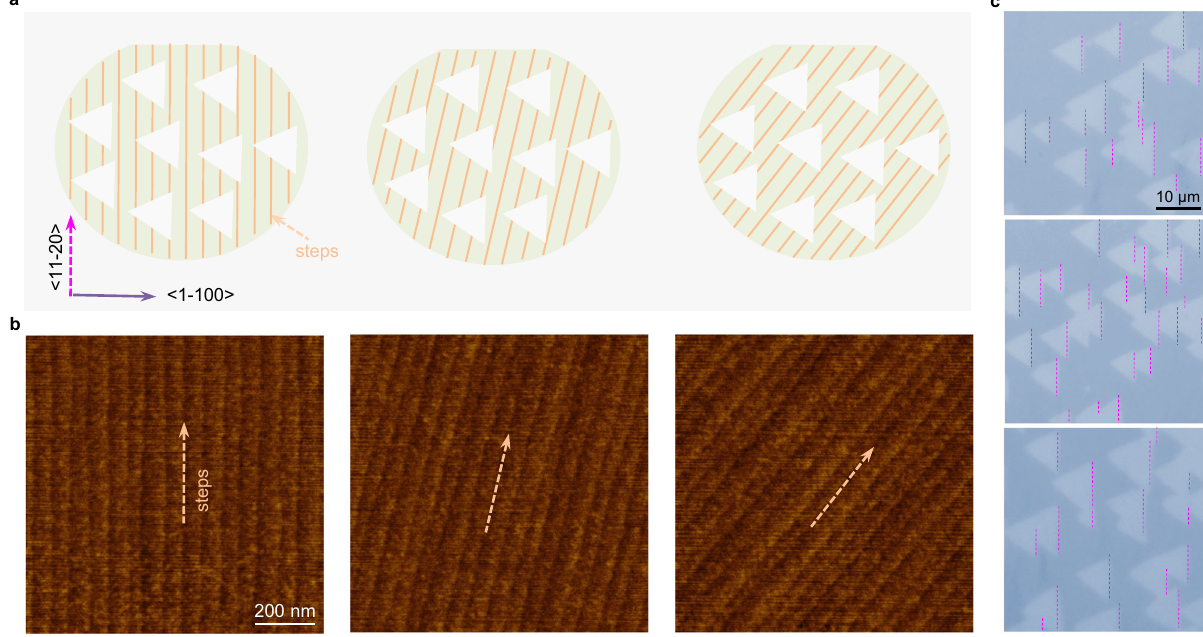
Fig. 2 | Growth of unidirectionally aligned MoS 2 grains on vicinal c-Al 2 O 3 with differentstepdirections.a SchematicdiagramsofMoS 2 grainsonthesurfacewith different step directions. The orange lines correspond to the parallel steps. b AFM images of the c-Al 2 O 3 surface. Different substrates exhibited different step